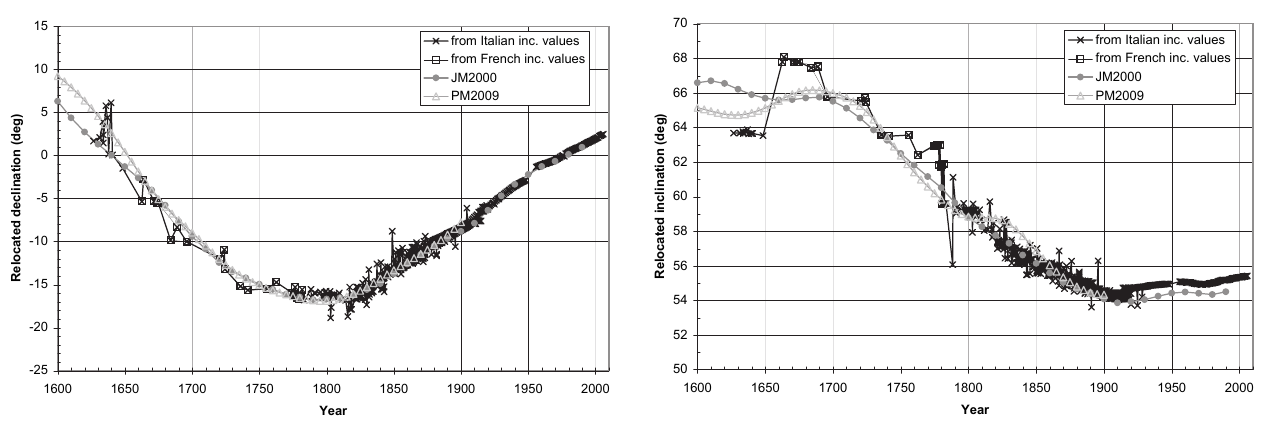
Fig. 6. Same figure as Fig. 2, modified by correcting years of Italian observations according to the 0.46 ± 0.19 ◦ yr − 1 westward drift calculated for Italian data.